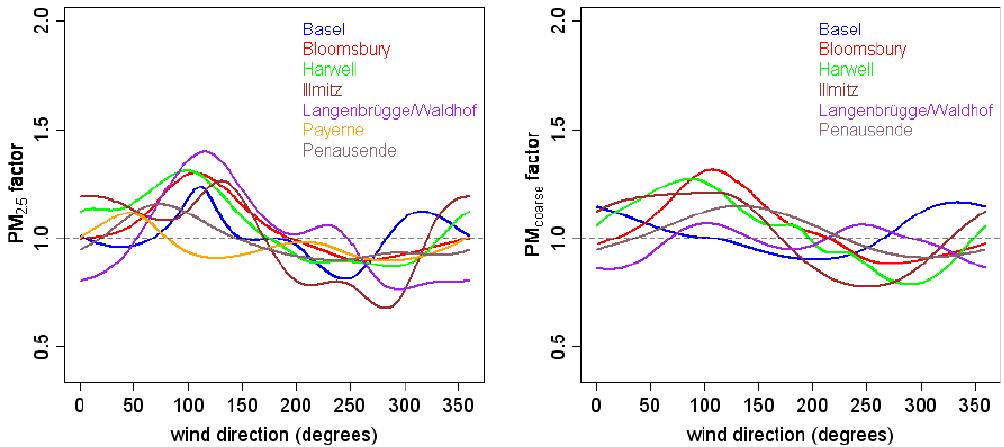
Fig. 4. PM 2 . 5 (left) and PM coarse (right) factors for wind direction at all sites. Payerne is missing from the PM coarse factor plot because wind direction was not selected for that site.